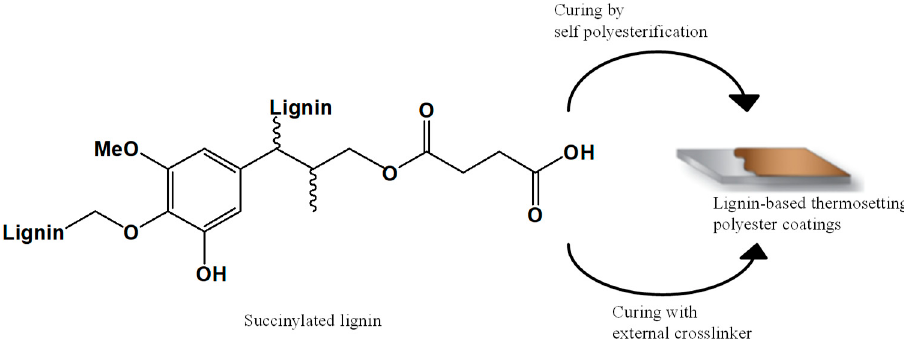
Figure 14. Process of curing the succinylated lignin in a substrate. Adapted from [65], with permission from American Chemical Society and Copyright Clearance Center, 2018.